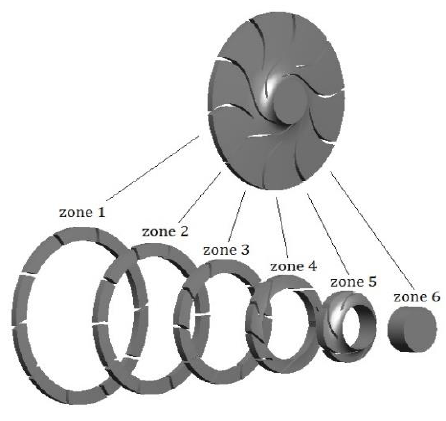
Figure 16. Zones of the impeller.